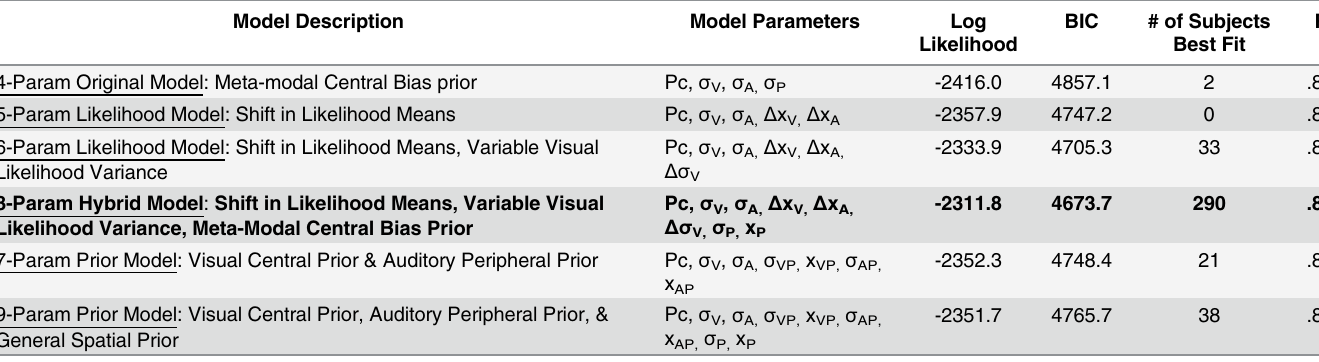
Table 2. Summary of modeling